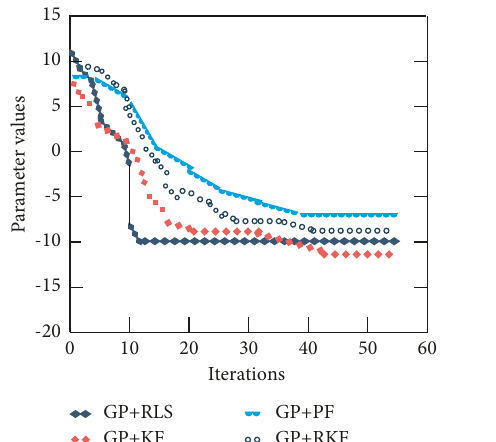
Figure 4: Convergence of parameter estimation error of the E- CELL model under Laplace noise.